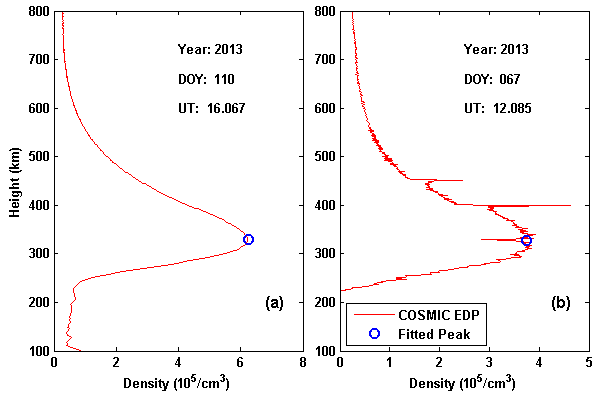
Figure 2. Samples of fitting the COSMIC EDP by Chapman α func- tion. DOY stands for “day of year”.